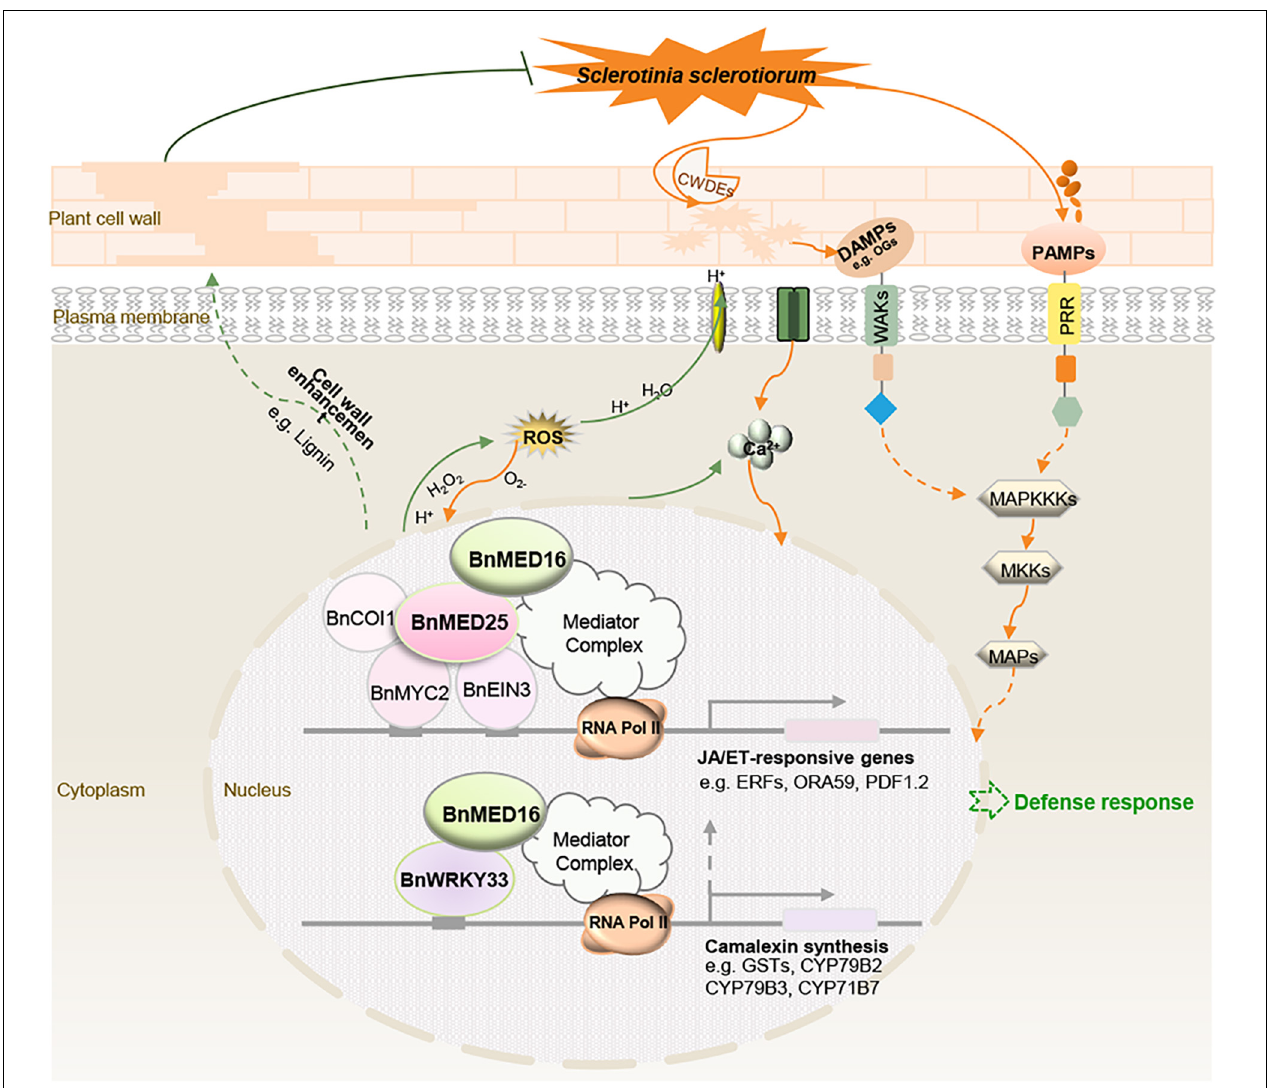
FIGURE 7 | Schematic model illustrating the proposed role of BnMED16 confers S. sclerotiorum resistance through increased activation of defense mechanisms in B. napus . BnMED16 positively regulates plant defense against S. sclerotiorum probably via BnMED25-mediated JA/ET defense pathways and BnWRKY33-activated defense signaling. Overexpression of BnMED16 results in the enhanced basal immunity in B. napus by promoting the accumulation and clearance of ROS upon S. sclerotiorum infection, increasing the expression of PR and phytoalexins genes, enhancing the cell wall reinforcement and cell wall-mediated resistance by lignification and pectins deposition, and inducing plant camalexin synthesis, and so on. CWDEs, cell wall-degrading enzymes; DAMPs, damage-associated molecular patterns; PAMPs, pathogen-associated molecular patterns; PRR, pattern recognition receptors; ROS, reactive oxygen species; MAPs, mitogen-activated proteins; MAPKKKs, MAP-kinase-kinase kinases; MKKs, MAP-kinase kinases; OGs, oligogalacturonides.